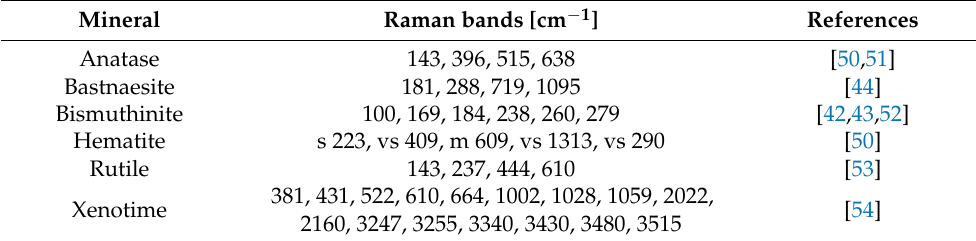
Table 2. Inclusions found in pyrite with their diagnostic Raman